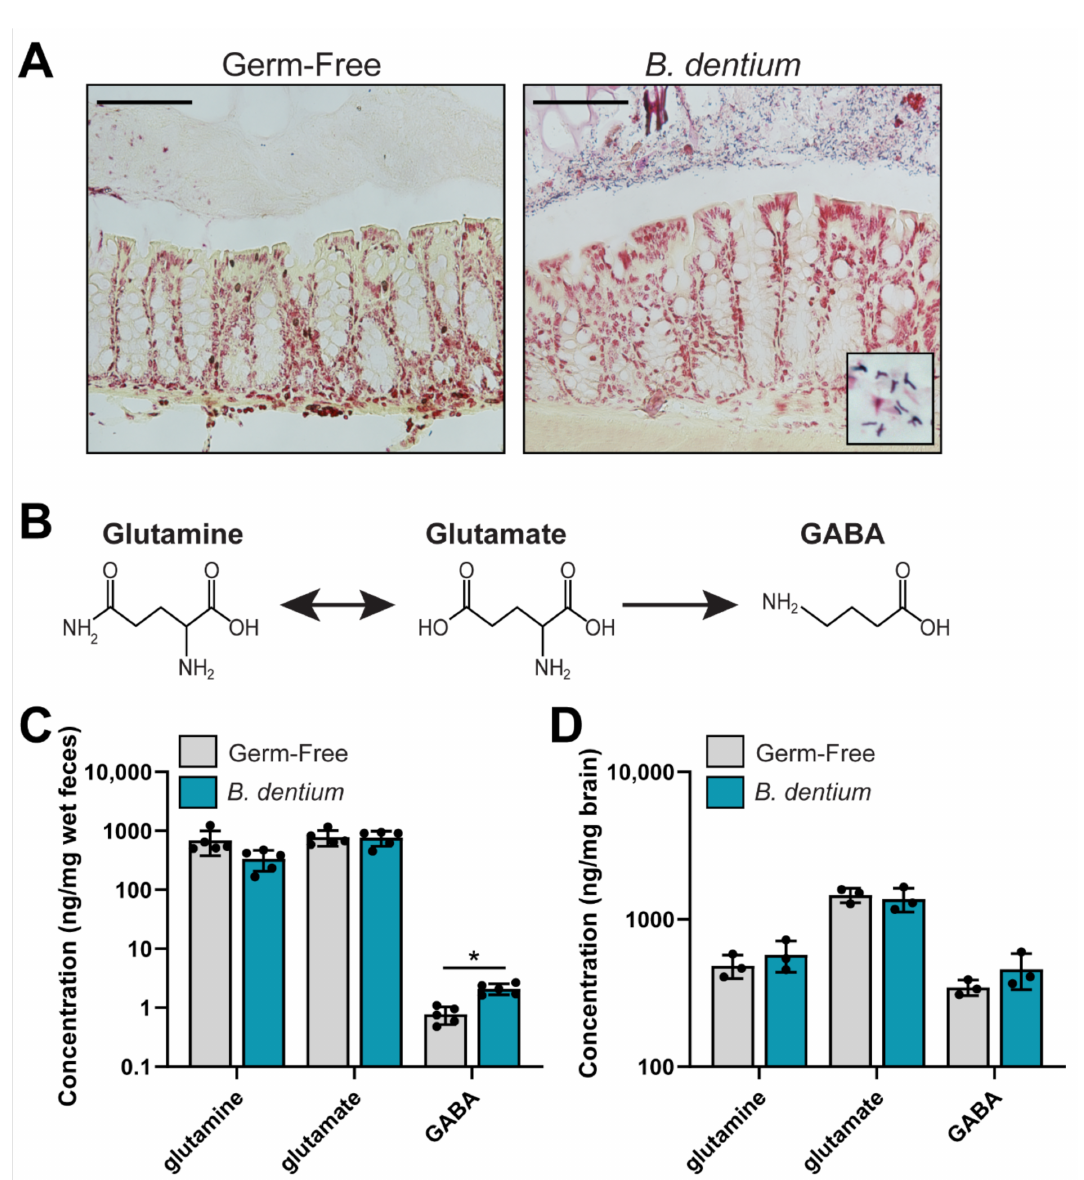
Figure 2. ( A ). Representative Gram stains of the germ-free and B. dentium mono-associated colon. Scale bar = 100 µ m. ( B ). Depiction of the glutamine, glutamate, GABA pathway. ( C ). Analysis of glutamine, glutamate, and GABA measured from a known mass of stool (ng/mg wet feces weight) by LC-MS/MS reflecting in vivo levels of these neurotransmitters from the germ-free and B. dentium mono-associated mice. ( D ). Concentrations of glutamine, glutamate, and GABA in a known mass of whole brain homogenate (ng/mg brain). n = 3–5 mice/group; two-way ANOVA, * p <